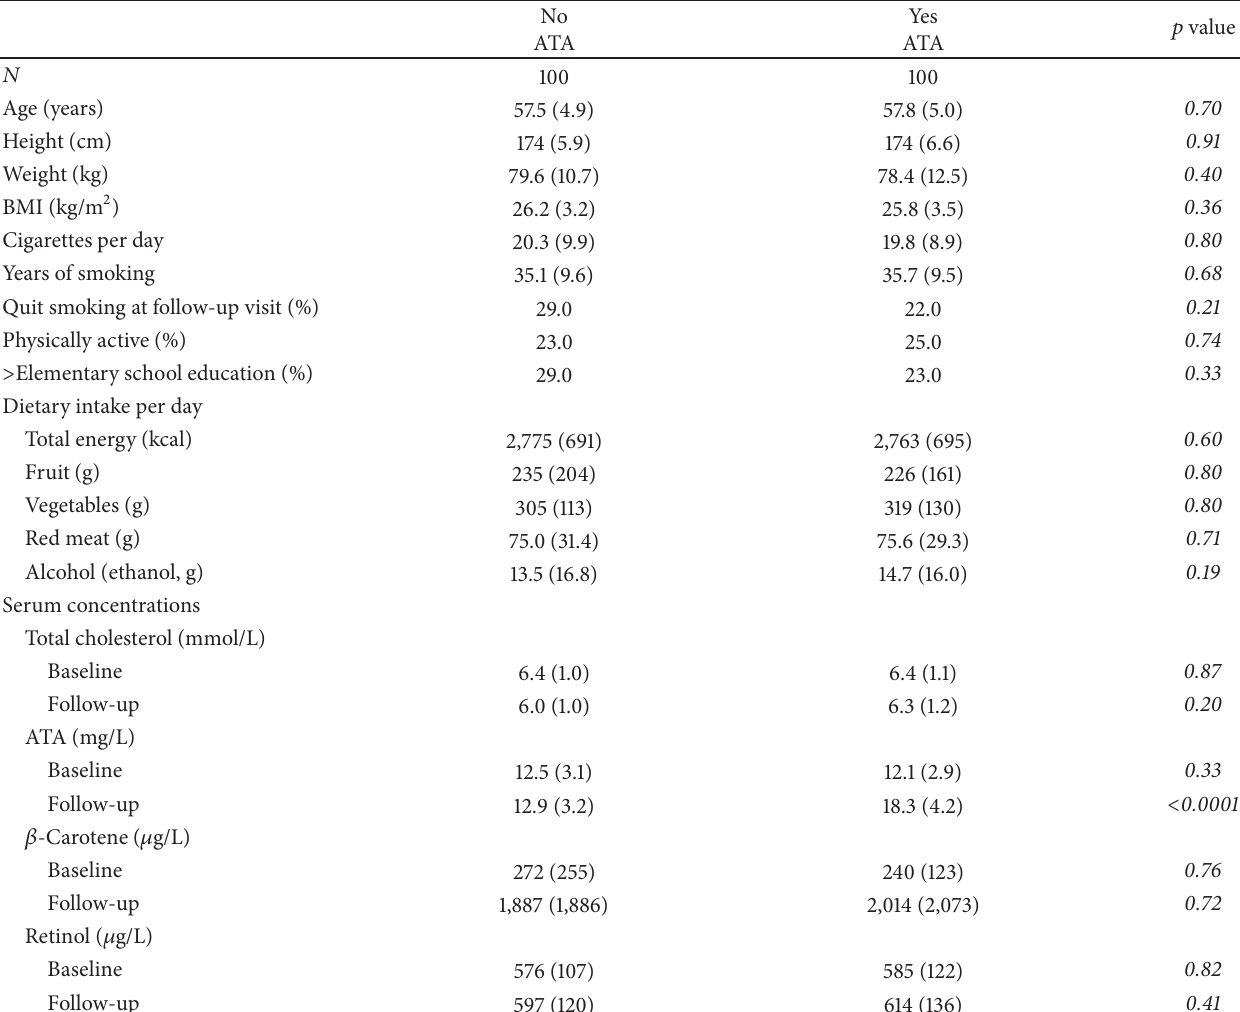
Table 1: Participant characteristics 1 by ATA assignment in the ATBC